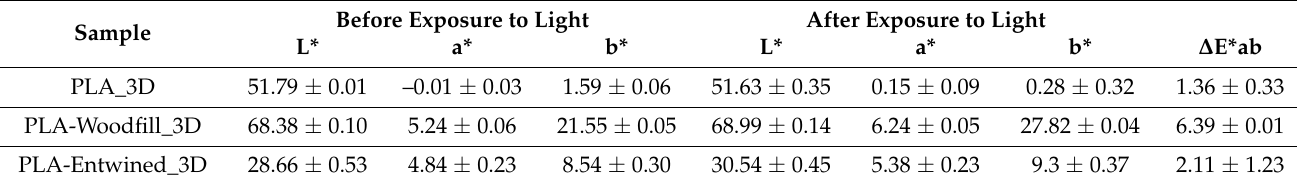
Table 2. L*, a*, b* and ∆ E*ab values of 3D printed samples before and after exposure to light; mean value ± SD.